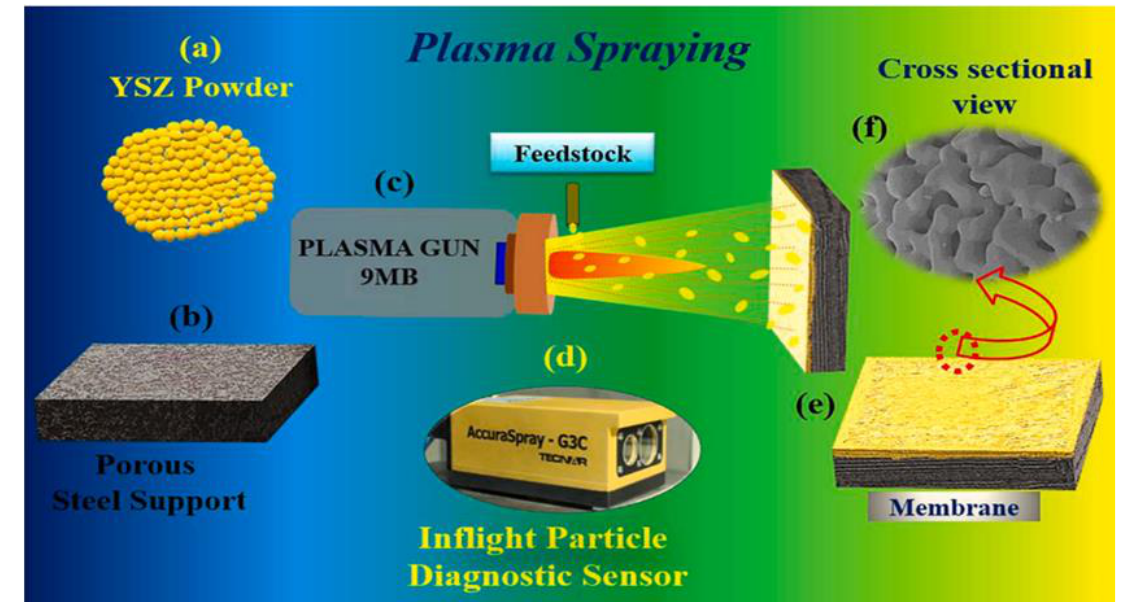
Figure 7. Schematic illustration of YSZ CM preparation process. (a) YSZ powder feedstock, (b) porous steel support, (c) plasma gun (9 MB) sprays the molten YSZ powder, (d) diagnostic sensor for temperature and velocity measurement, (e) YSZ membrane after its deposition onto porous steel support, (f) YSZ membrane cross-sectional image [238]. Reprinted with permission.